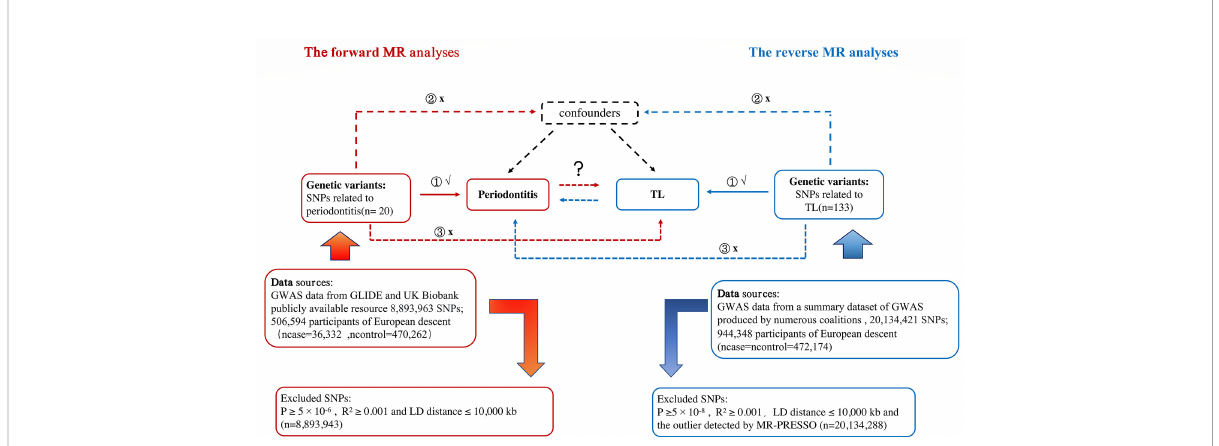
FIGURE 1 Study Design Sketch: Periodontitis is exposed in red in the forward MR analysis, and TL is the outcome. Exposure is represented by the color blue in the reverse MR analysis, periodontitis is the outcome. Abbreviation: TL, telomere length; MR, mendelian randomization; SNP, single nucleotide